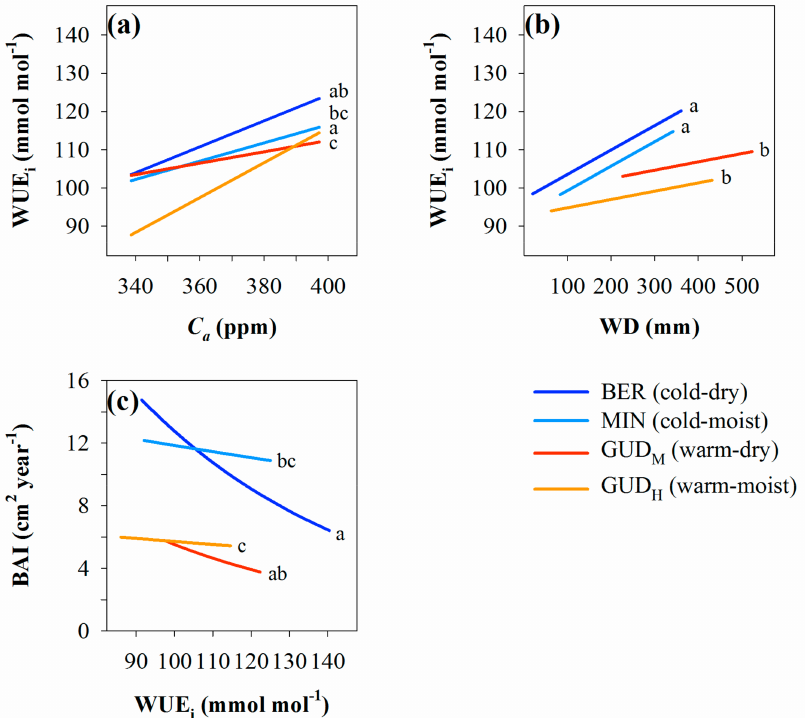
Figure 6. The effects of ( a ) atmospheric CO 2 concentration ( C a ) and ( b ) growing season water deficit (WD; evapotranspirative demand exceeding precipitation) on intrinsic water use efficiency (WUE i ) as a function of region (Central Siberia, Eastern Spain) and site (dry, moist). ( c ) The effect of WUE i on BAI as a function of region and site. For each combination of region and site, different letters indicate significant differences between slopes of responses according to a Student’s t -test ( α =